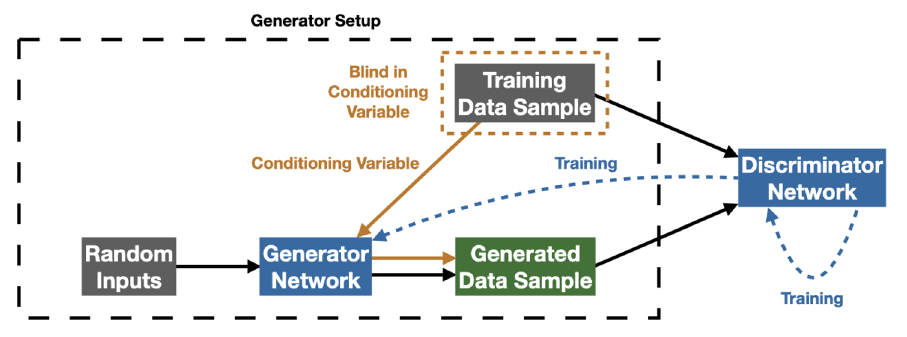
Figure 11 . Schematic representation of a conditional generative adversarial